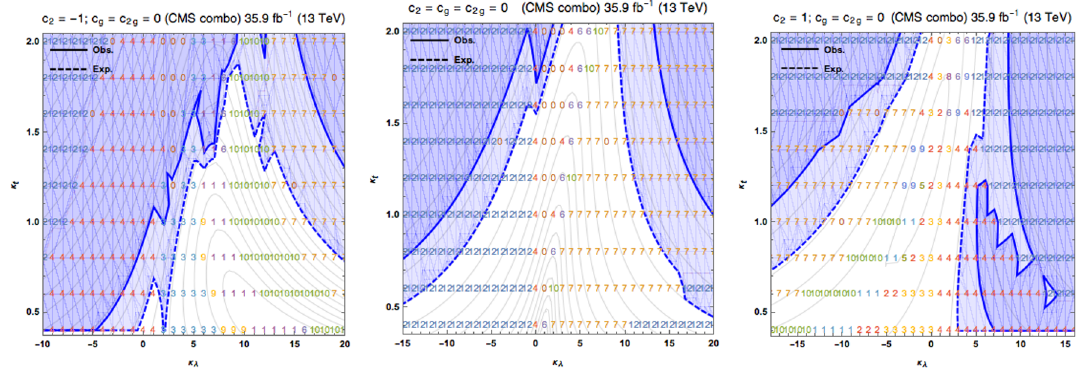
Figure 12 . 2D scans in the κ λ × κ t phase space for 3 values of c 2 = − 1 , 0 , 1 (from left to right), see text for details.